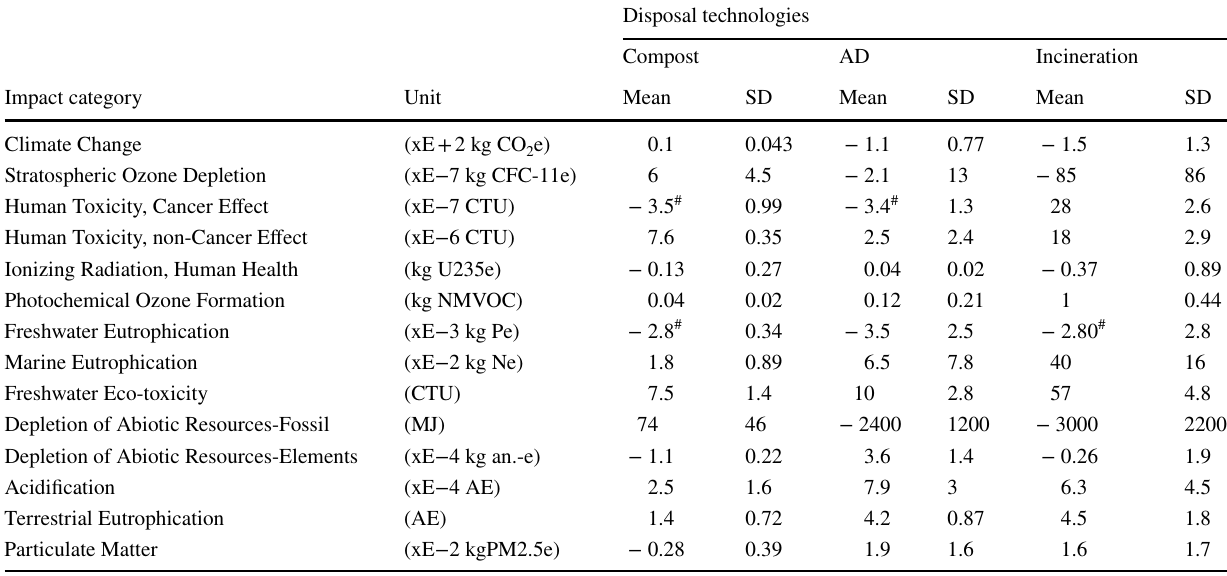
Table 3 Characterised results of impact categories for the study scenarios